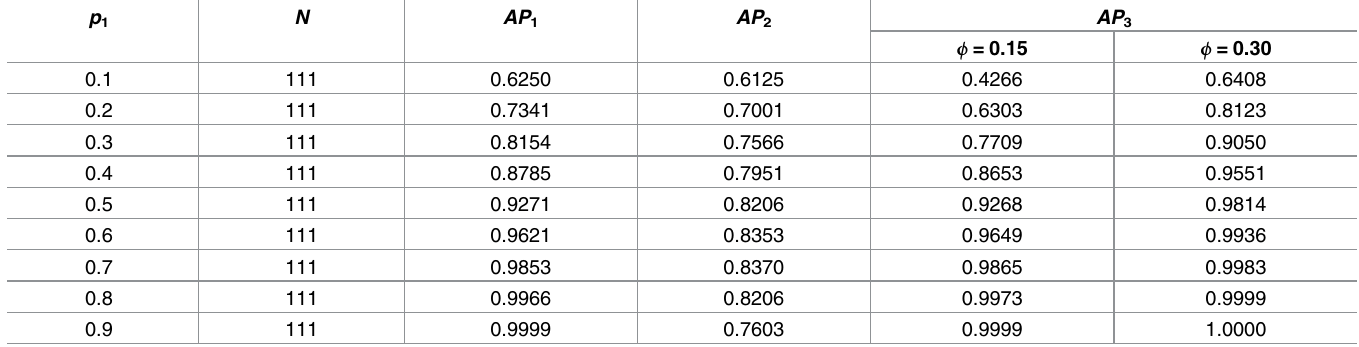
Table 4. Sample size and assurance probabilities for observing criteria (i), (ii), and (iii) given α = 0.025, β = 0.1, ( Δ 1 , Δ 2 ) = (3,0.45), ( σ 1 , σ 2 ) = (6,1), ( γ 1 , γ 2 ) = (0.5, 0.5), and ρ 12 =